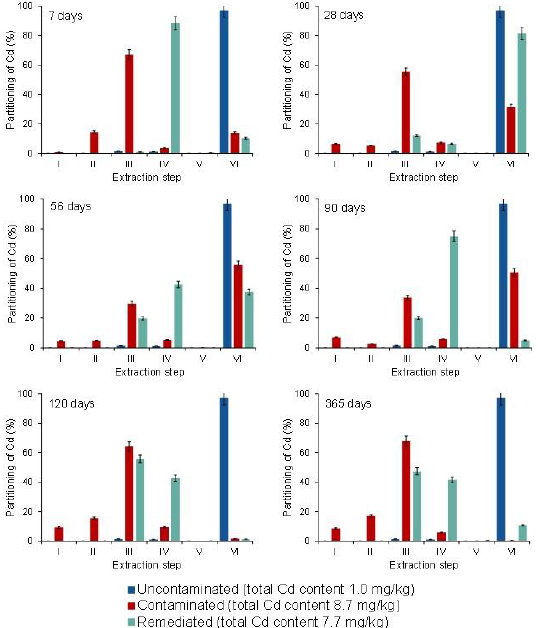
Figure 3. Partitioning of Cd in uncontaminated, contaminated, and remediated soil samples with time elapsed after the remediation. I water-soluble; II exchangeable; III bound to carbonates; IV bound to Fe/Mn oxides and hydroxides; V bound to organic matter; VI bound to silicate lattice.